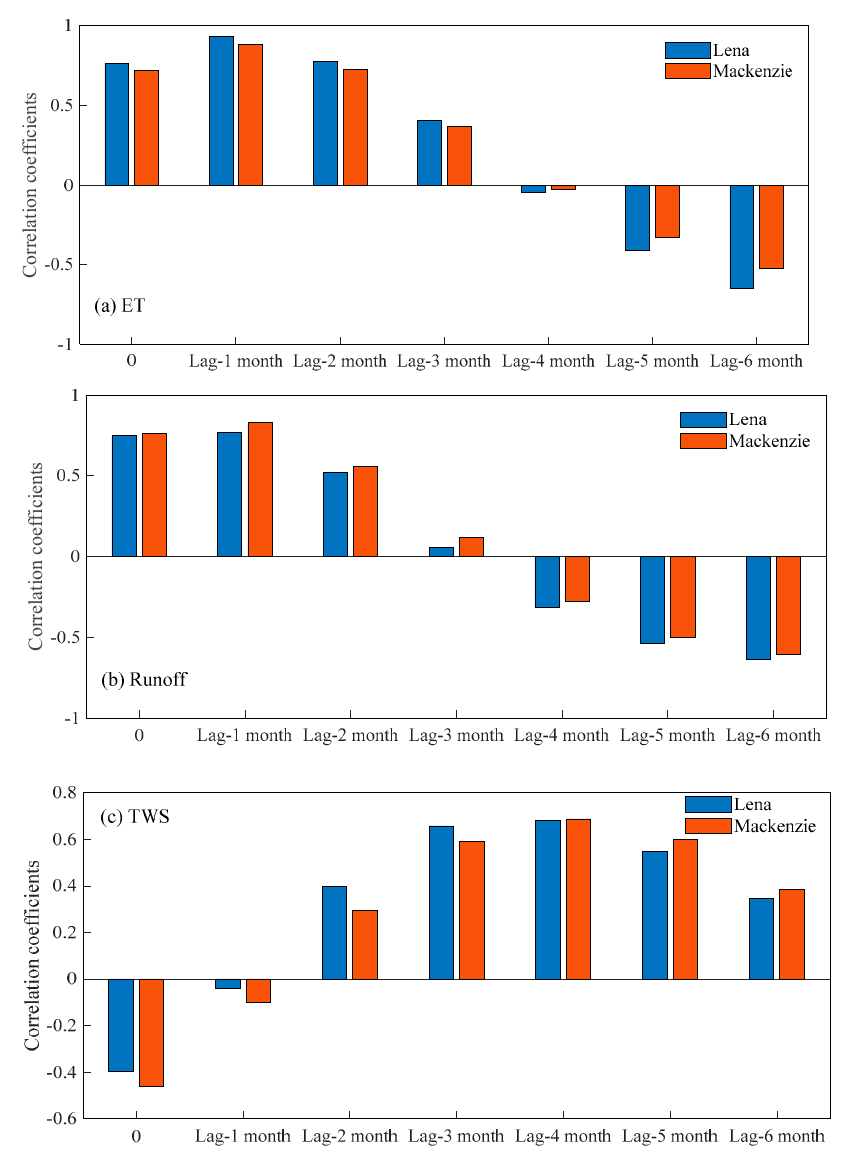
Figure 11. The time lag of the correlation coefficient between precipitation and ET ( a ), runoff ( b ) and TWS ( c ) in the LRB and MRB during 2003–2016.